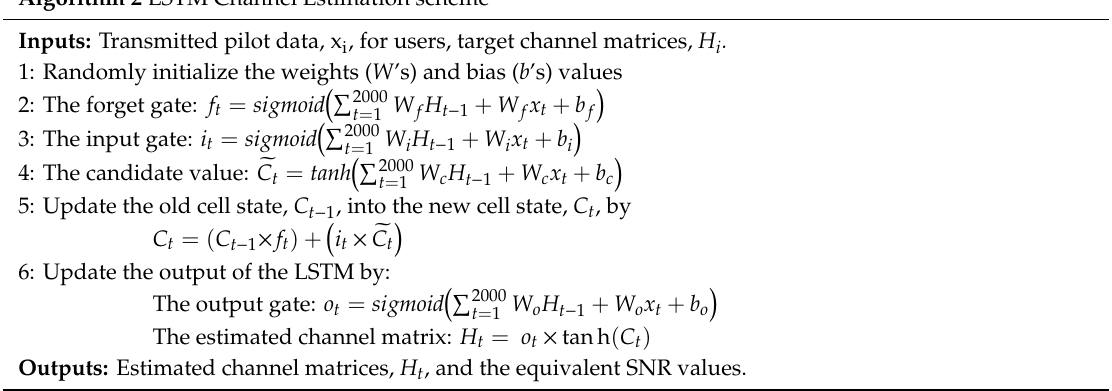
Algorithm 2 LSTM Channel Estimation